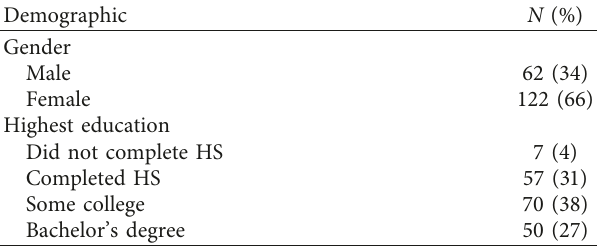
Table 2: Respondent